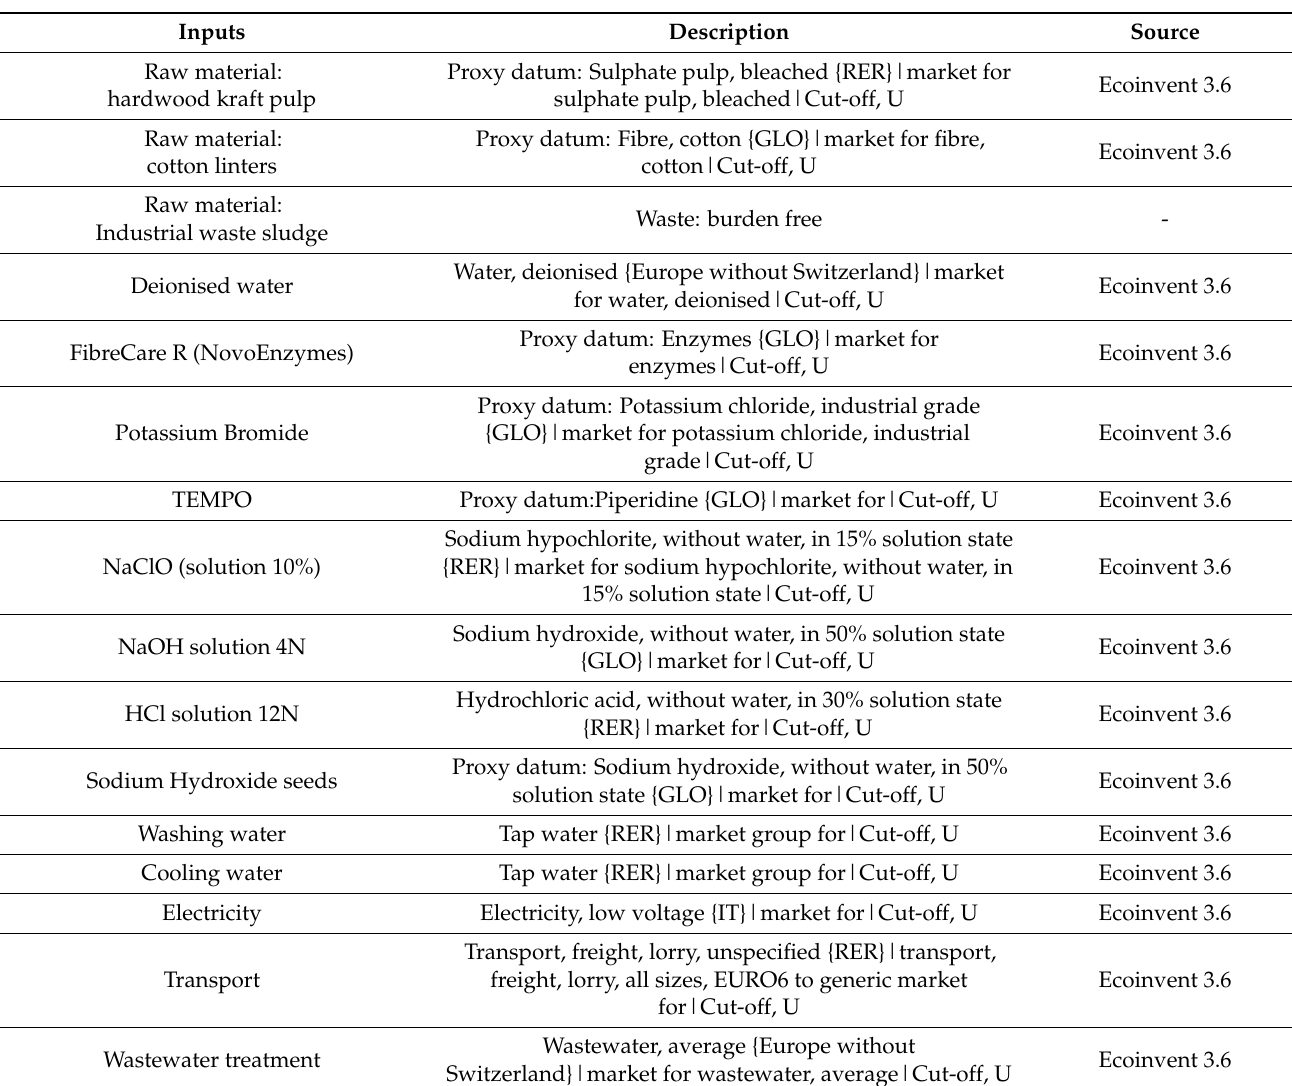
Table 6. Modelling and sources of the secondary